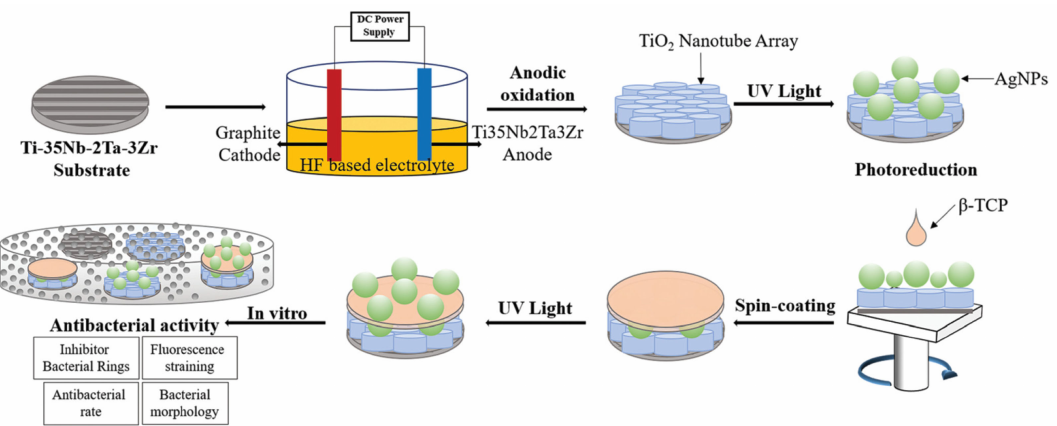
Figure 2. Surface modification of Ti–35Nb–2Ta–3Zr with nanotubes, AgNP, and TCP. Reproduced from Ref. [20] with permission from the Royal Society of Chemistry